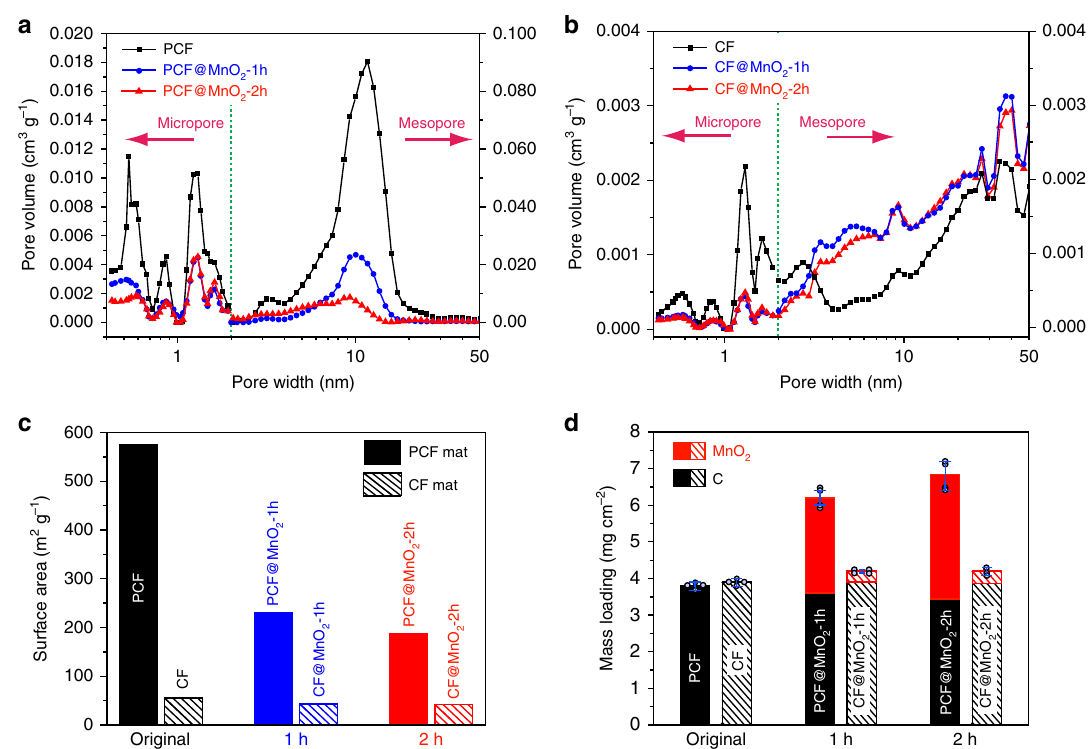
Fig. 3 Physical characterizations. a , b Pore size distributions of (a) PCF, PCF@MnO 2 -1h, and PCF@MnO 2 -2h and (b) CF, CF@MnO 2 -1h, and CF@MnO 2 -2h. The micropore and mesopore size distributions are measured by the physisorption of carbon dioxide (at 273 K) and nitrogen (at 77 K), respectively, and calculated using the density functional theory. Note the different scales in the micropore and mesopore ranges. Compared to PCFs, CFs contain one order of magnitude lower mesopore volume. The high mesopore volume of PCFs con fi rms that the mesopores are interconnected and thus are accessible to the adsorbates. c The surface areas of PCFs and CFs before and after loading MnO 2 . The deposition reaction time increased from 0 to 2 h. d Histograms of the mass loadings of (black) carbon fi bers and (red) MnO 2 on supercapacitor electrodes. The solid and dashed bars represent electrodes composed of PCFs and conventional CFs, respectively. The error bars in ( d ) are standard deviations determined from at least four independent